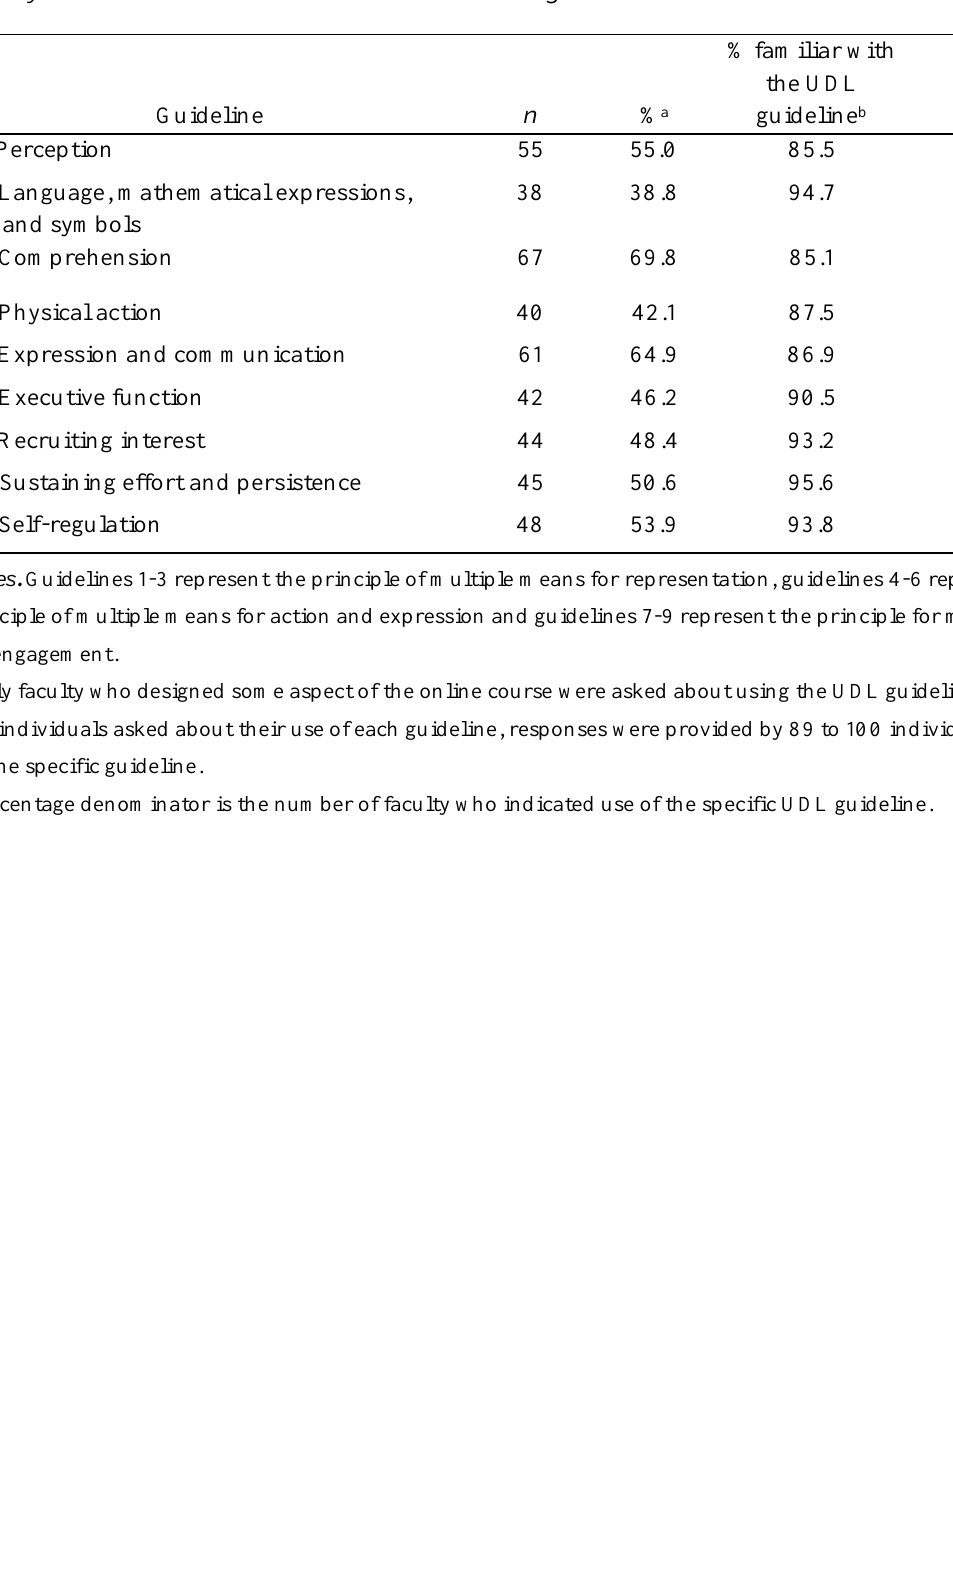
Faculty Use of UDL Guidelines in Online Course